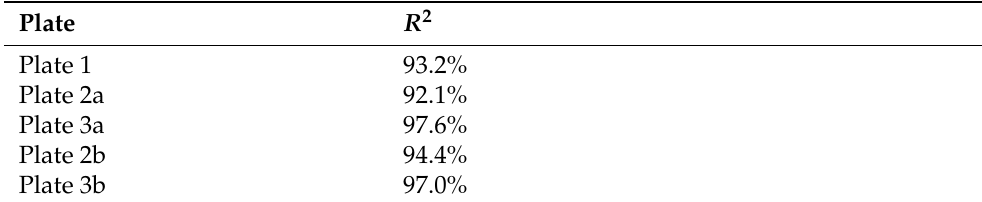
Figure 7. Effect of neighbor samples on Saturation. Columns 1, 2, 5, 6, 9, and 10 are negative samples. known negative samples to determine a fixed threshold or using the negative samples in